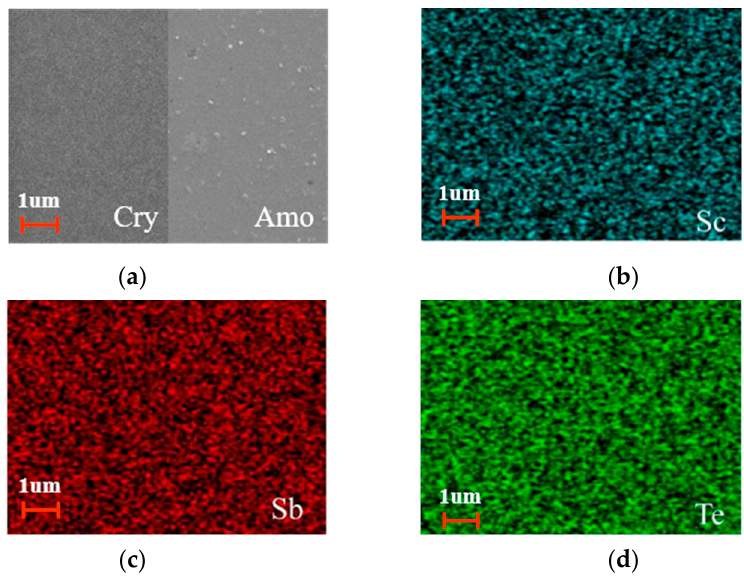
Figure 1. ( a ) SEM images of SST film; ( b ) EDS element maps of Sc in SST film; ( c ) EDS element maps of Sb in SST film; ( d ) EDS element maps of Te in SST film.